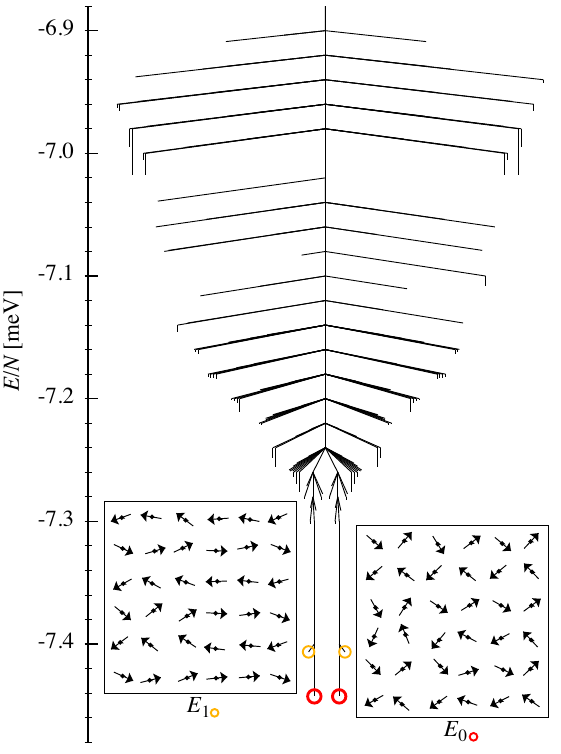
FIG. 5. Disconnectivity graph of the weakly disordered, square- lattice ensemble illustrated in Fig. 1(a). Notice that the degenerate global minima (red circles) and hubs (orange circles) are distinctly more stable than all other local minima. The insets illustrate the magnetic configuration at one of the global minima ( E 0 ) and the closest hub ( E 1 ). The twofold degeneracy is a consequence of time-inversion symmetry. See also Fig. 2 [95].